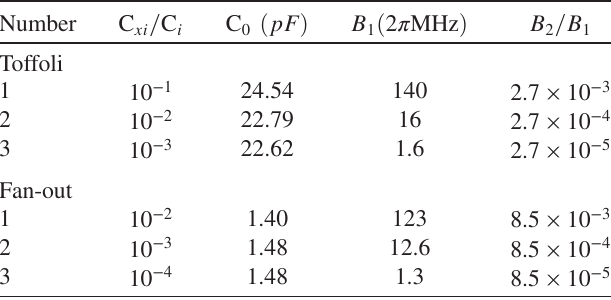
Table III provides sample parameters that could be used for realization of the adiabatic gates. Identical circuit parameters are assumed for the i ¼ 1 ; … ; k control (target) qubits, which are different from the ones of the sole target (control) qubit (labeled by 0) for the Toffoli (fan-out) gate. The parameters are tuned to establish degeneracy between TABLE III. Example parameters (rounded values) for the implementation of adiabatic multiqubit gates in superconducting circuits. The scheme parameters in this table for Toffoli (fan-out) are E 0 ¼ 20 ð 1 . 25 Þ ns − 1 , E i ¼ 1 . 25 ð 20 Þ ns − 1 , C i ¼ 5 (20) pF. = 2 π ¼ 3 . 2 The detuning parameters in Toffoli (fan-out) are δ 1 t 1 c 2 t 0 c and α c = 2 π ¼ 4 (13.4) GHz. The presented coupling and detuning strengths are calculated for k ¼ 2 . Adjustment is required for other qubit numbers k to preserve the same coupling parameters. For example, in the k ¼ 20 Toffoli (fan-out) gate, the adjusted value of row 2 is C 0 ¼ 21 . 8953 (1.3854)